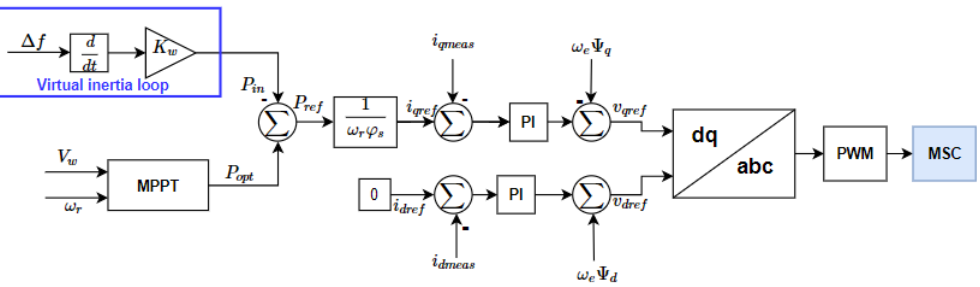
Figure 7. Modified control scheme of